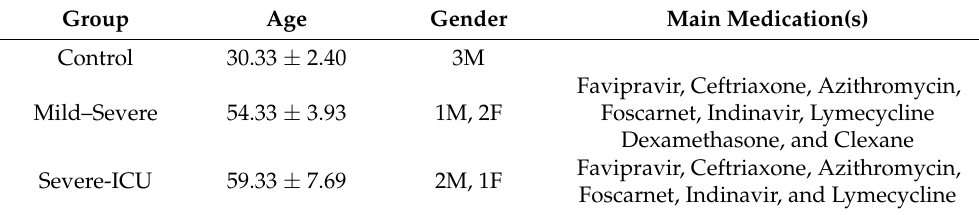
Favipravir, Ceftriaxone, Azithromycin, Foscarnet, Indinavir, Lymecycline Dexamethasone, and Clexane Favipravir, Ceftriaxone, Azithromycin, Foscarnet, Indinavir, and Lymecycline